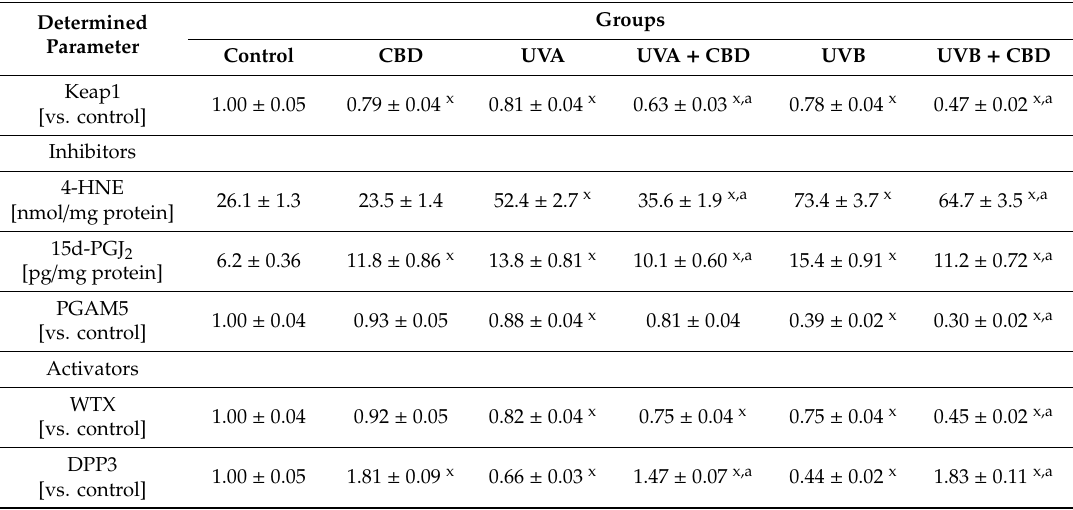
Figure 5. E ff ect of cannabidiol (CBD) on Nrf2 transcriptional activity and the level of its activators and inhibitors in keratinocytes exposed to UVA (30 J / cm 2 ) and UVB (60 mJ / cm 2 ) irradiation. Mean values ± SD of five independent experiments are presented: x statistically significant di ff erences vs. control group, p < 0.05; a statistically significant di ff erences vs. group without cannabidiol, p < 0.05. Table 2. E ff ect of cannabidiol (CBD) on Keap1 expression and the level of its activators (determined by Western blotting) and inhibitors (determined by Western blotting–PGAM5 and by LCMS–4-HNE and 15dPGJ 2 ) in keratinocytes exposed to UVA (30 J / cm 2 ) and UVB (60 mJ / cm 2 )